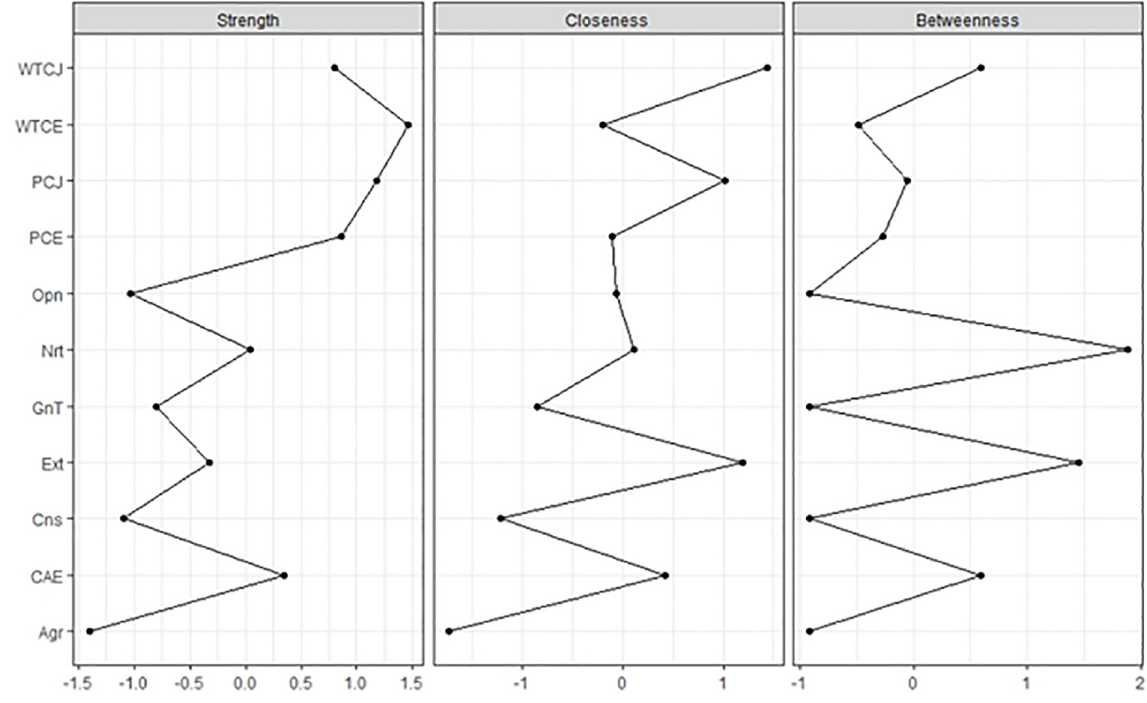
Fig 2. Centrality indices are shown as standardized z-scores. The abbreviations are the same as Fig